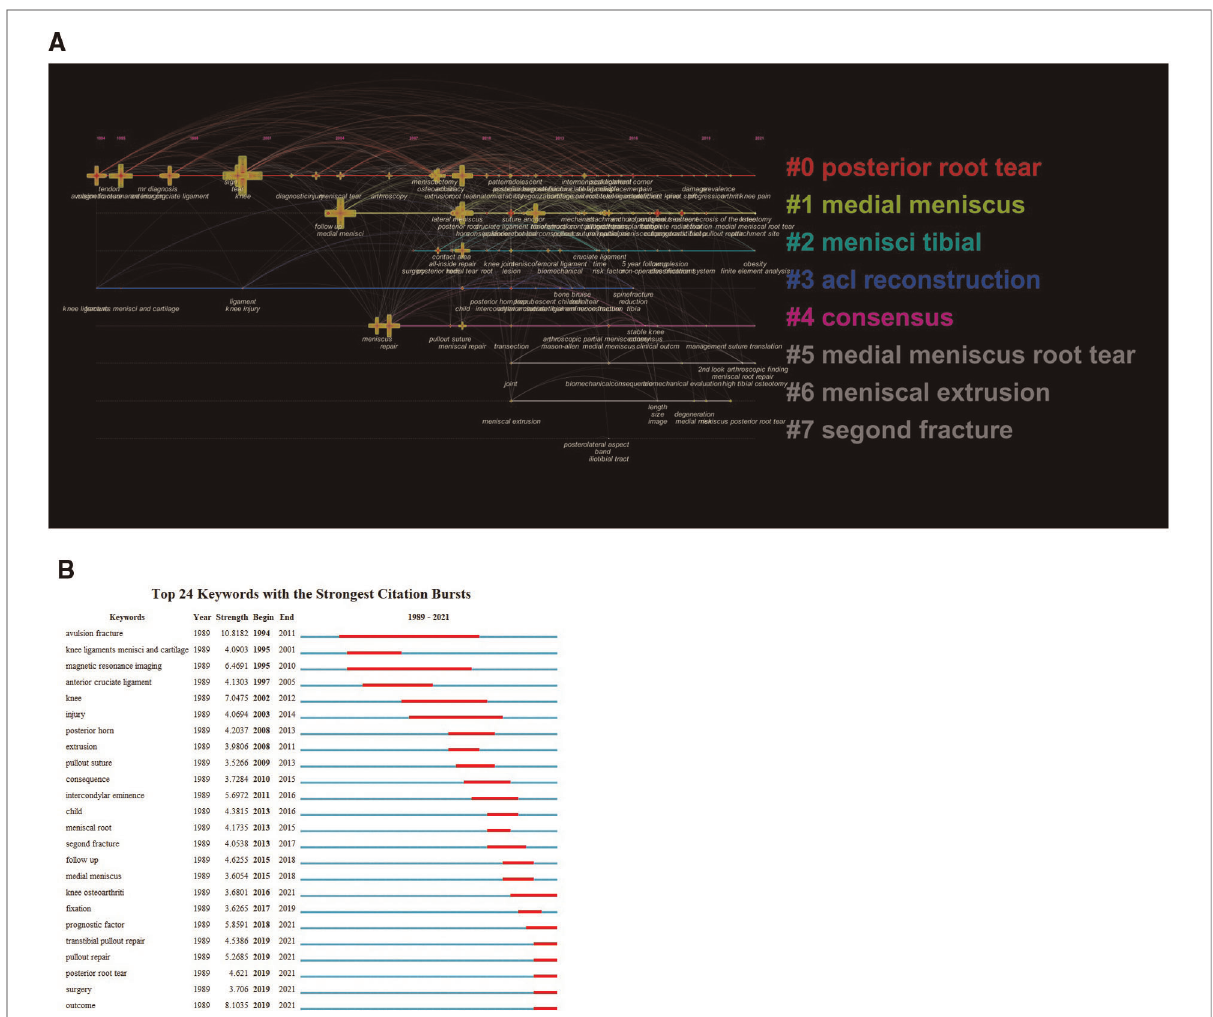
FIGURE 8 The co-occurrence network and clusters of keywords in publications on meniscal root tears research. ( A ) The timeline view of cluster map of co- occurrence network of keywords ( B ) The strongest citation bursts of